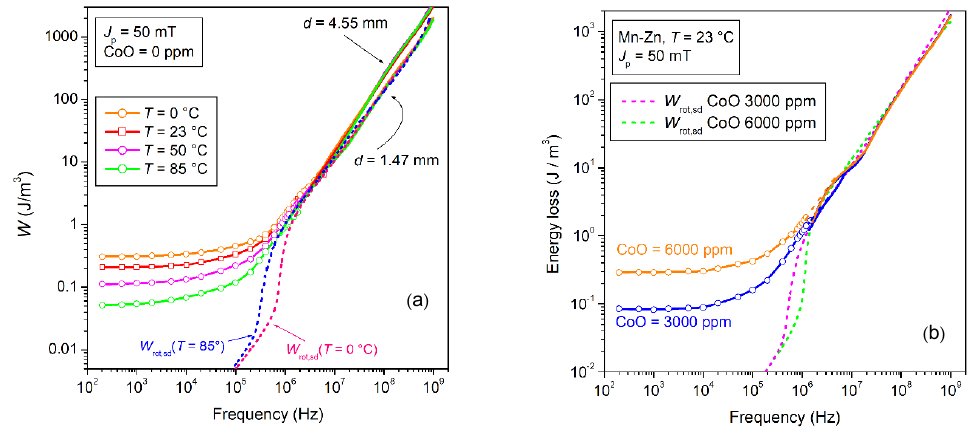
Figure 15. The rotational loss component W rot,sd ( f ), calculated with Equation (29), predicts the high-frequency magnetic losses in thin samples and thick ones, once the latter are deprived of the eddy current loss contribution. The theory of W rot,sd ( f ) predicts, however, that the magnetic softening induced by a distribution of the effective anisotropy widening towards low values is conducive to higher rotational losses at intermediate frequencies (usually between some 100 kHz and a few MHz), which partially compensate for the companion decrease in the dw-generated contributions W h and W exc,sd ( f ). We then observe that the decrease in < K eff >, be it induced by an increase in temperature ( a ) or by optimal CoO addition ( b ), leads to opposite dissipative responses by rotations and dw displacements.